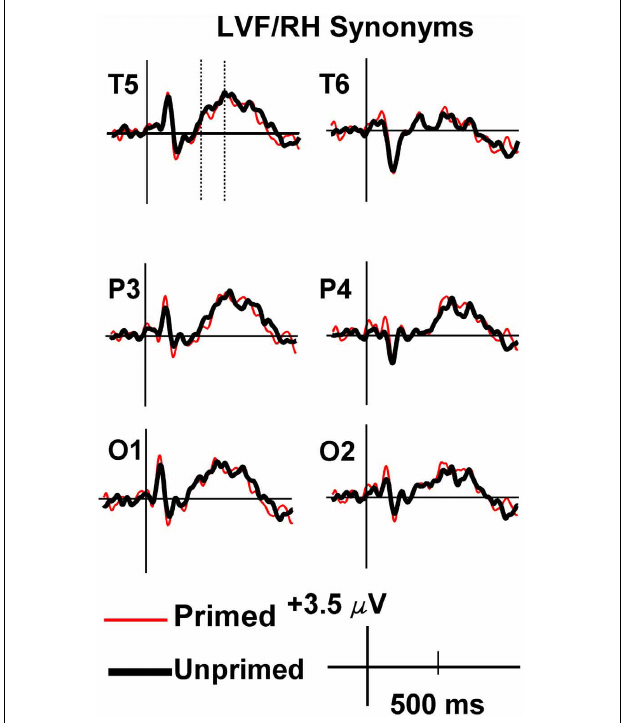
FIGURE 4 | Grand average ERPs recorded to synonym targets presented to the RVF/LH. The Primed condition is printed in red, and the unprimed in black. Baseline correction has been performed from the target (the second stimulus in each trial). The N400 was significantly more positive for synonyms of rare words than to unrelated words (i.e., demonstrating facilitation).